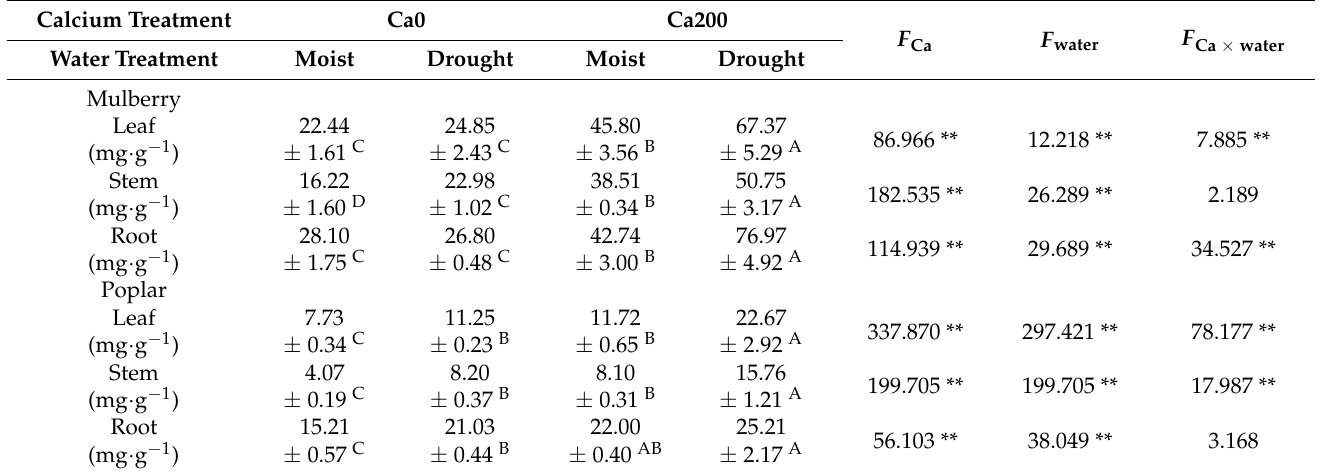
Table 2. Effect of water and Ca treatments on Ca concentration in leaf, stem, and root of the two species. Different letters indicate significant differences ( p < 0.05) among treatments. Treatment values shown as mean ± SE (n = 6). Results of two − way ANOVA addressing effects of Ca and water treatments are summarized at the bottom. ** indicate that the F value is significant at 0.01.